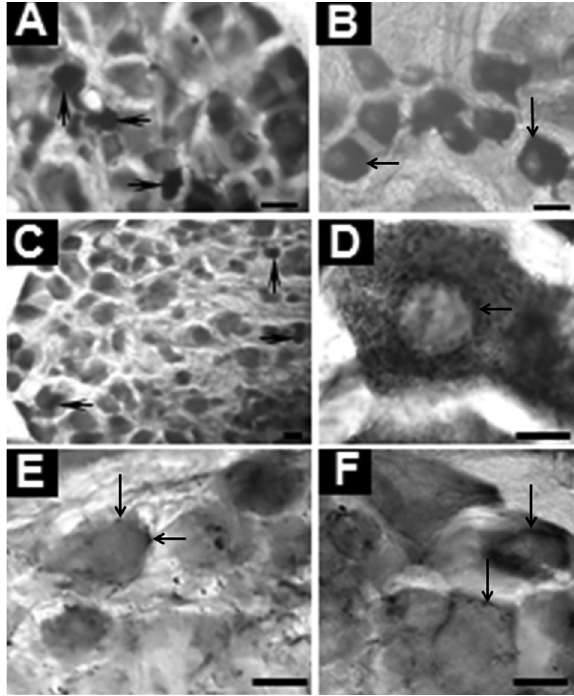
Figure 4. Cross-section of a naive ( A , C , E ) and transected ( B , D , F ) Ranacatesbeiana ’sdorsalroot ganglion. Note the larger number of cells positive for the NADPH-diaphorase reaction ( B ), the c-Fos- like immunoreactivityin the nucleus ofthe neuron( D ),and the more intense tyrosine hydroxylase-like immunoreactivity surrounding neurons ( F ) 3 days after sciatic nerve transection. Arrows point to neurons positive for NADPH-diaphorase ( A ) and c-FOS ( C ). Scale bars: A and B = 20 m m, C = 10 m m, D and F = 40 m m.